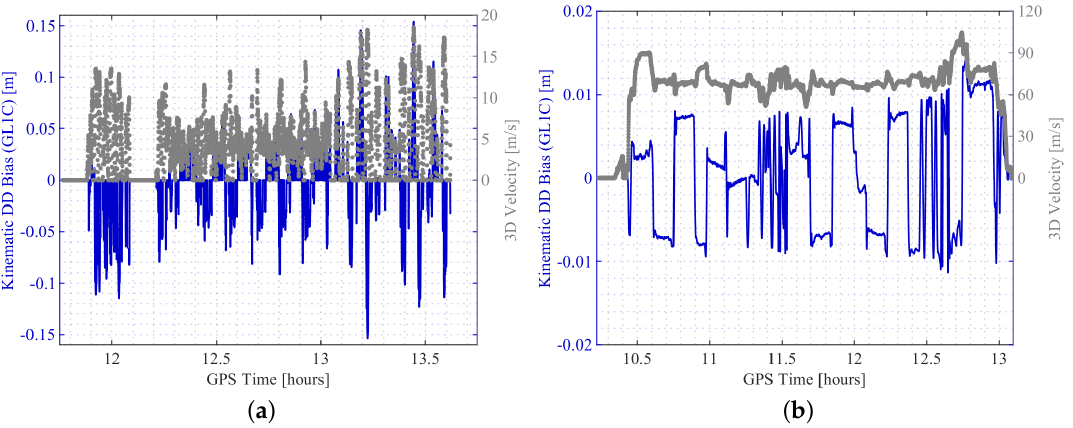
Figure 6. Kinematic double difference (DD) bias. ( a ) Terrestrial experiment: Kinematic DD bias of GPS